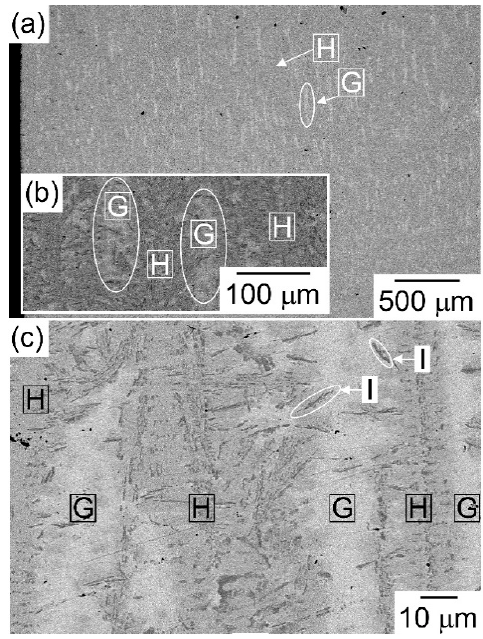
Figure 8. SEM-BSE images of the arc-melted ingots of the B-added CoCrCuFeMnNiB 0.2 (Cu1B02) HEAs. ( a ) Low-magnification image, ( b , c ) magnified image of Figure 8a.